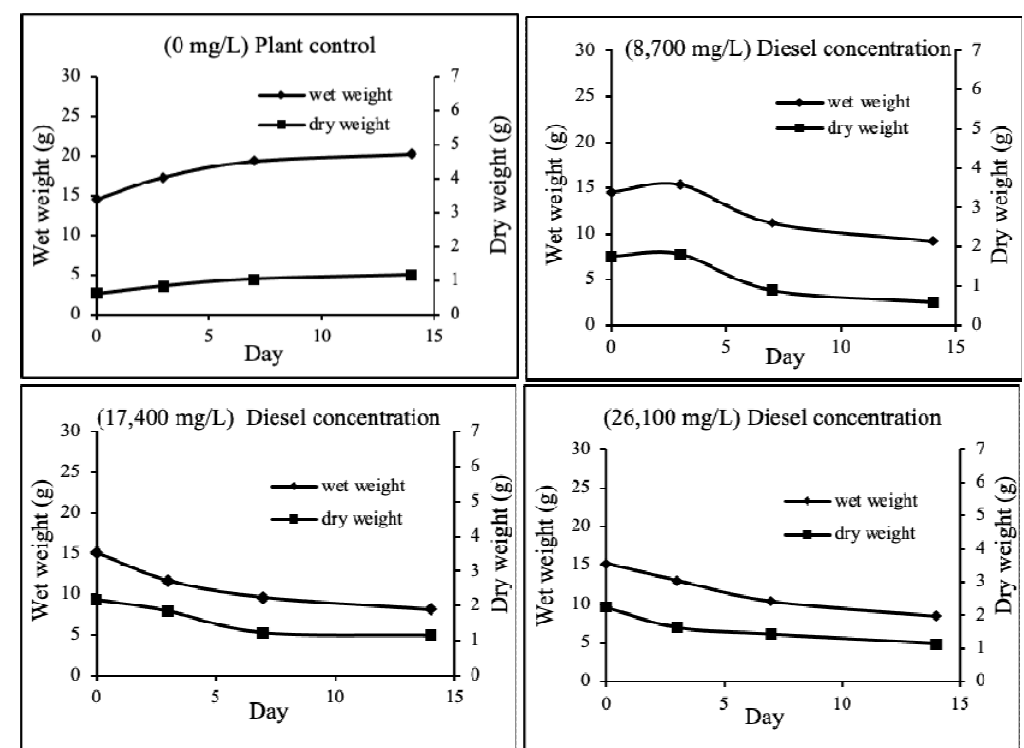
Fig. 4. Growth parameters of Salvinia molesta with different diesel contamination